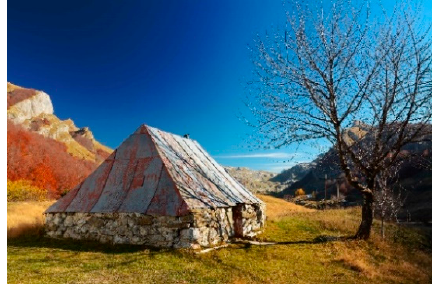
Figure 30. Metal covered roof - Mokra, photo: I. Lakovi ć .